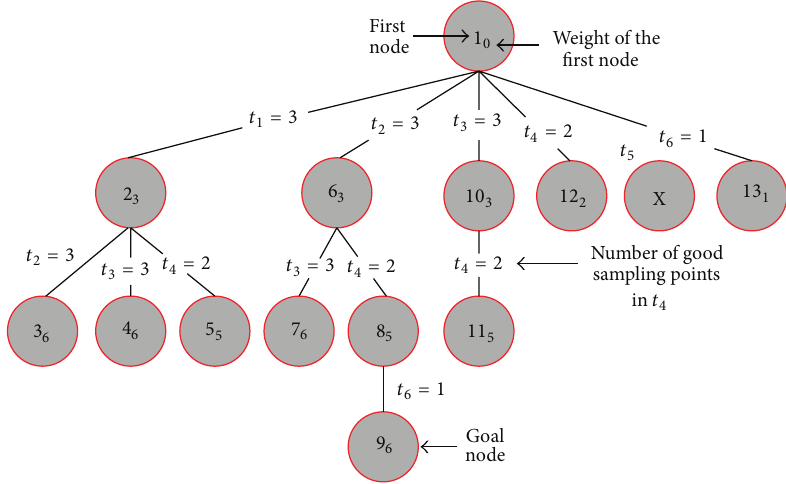
Figure 2: The DFS tree generated by the proposed algorithm.